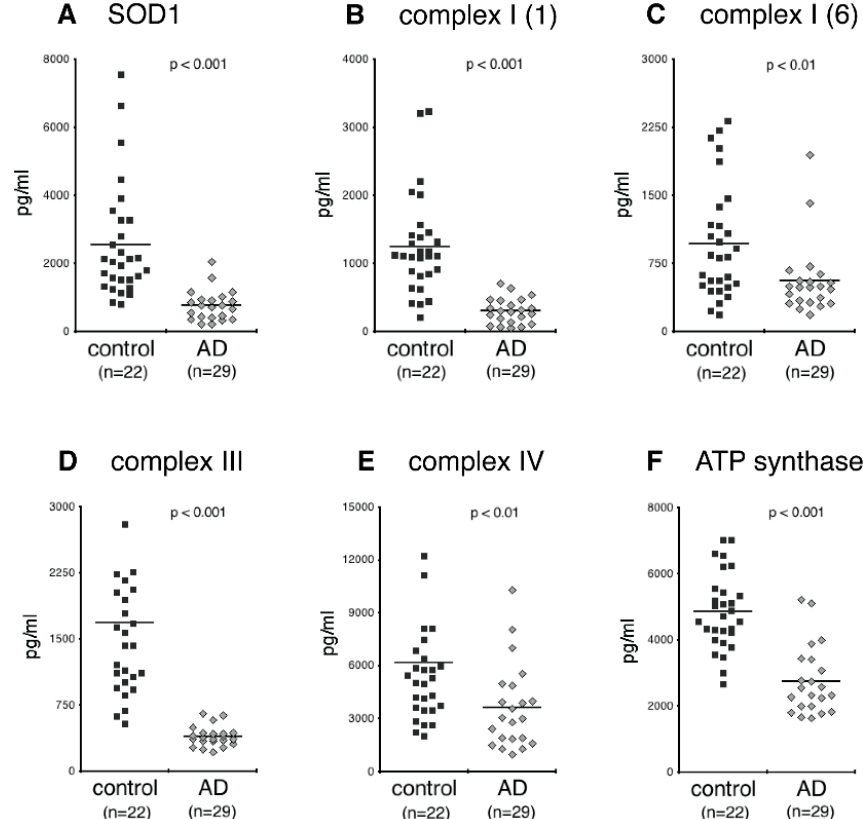
Figure 2. Levels of SOD1 and constituents of the mitochondrial oxidative phosphorylation system in plasma NDEVs of control and AD. Each data point represents the value for one study participant. The mean ± S.E.M. of control and AD groups, respectively, were 2252 ± 313 pg/mL and 769 ± 96 pg/mL, p < 0.001, for SOD1 ( A ); 1254 ± 135 pg/mL and 306 ± 40 pg/mL, p < 0.001, for subunit 1 of complex I ( B ); 972 ± 116 pg/mL and 558 ± 85 pg/mL, p < 0.01, for subunit 6 of complex I ( C ); 1692 ± 153 pg/mL and 399 ± 24 pg/mL, p < 0.001, for subunit 10 of com- plex III ( D ); 6209 ± 752 pg/mL and 3647 ± 513 pg/mL, p < 0.01, for subunit 1 of complex IV ( E ); 4863 ± 213 pg/mL and 2762 ± 221 pg/mL, p < 0.001, for ATP synthase ( F ). All values were normal- ized for content of the exosome marker CD81. Statistical significance of differences in values between control and AD groups were calculated by two sample t